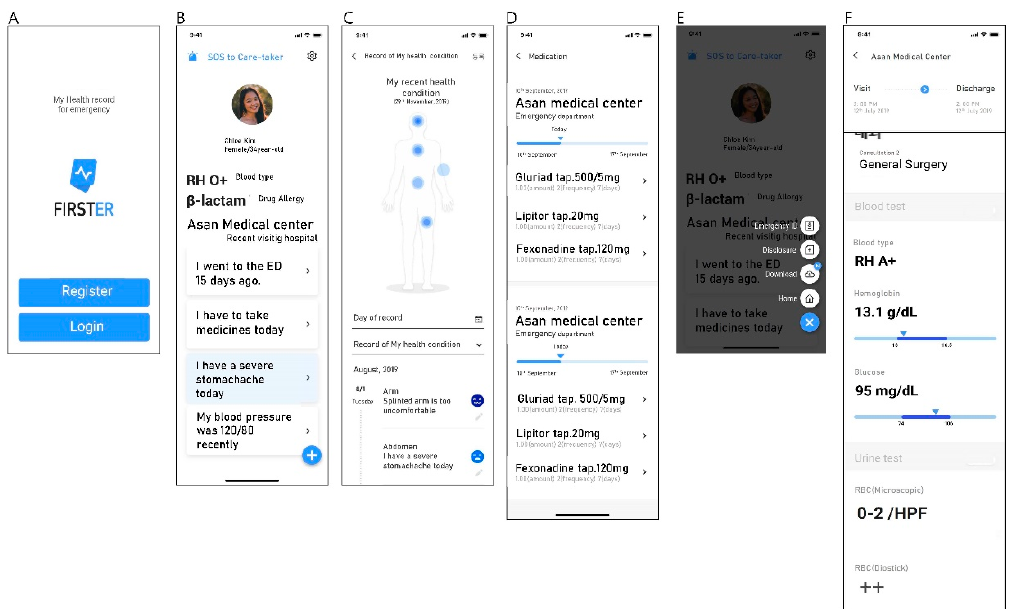
Figure 4. Screenshots of the FirstER user interface (translated to English). ( A ) Introduction page for registration and log-in; ( B ) main page for user’s information, ED visiting history, medication alarms and PGHD at a glance; ( C ) details of PGHD contents: “My recent health condition”; ( D ) prescribed medication (duration, amount, and frequency) and buttons linked to detailed drug information; ( E ) emergency ID, useful information when a user visits an emergency department, and buttons linked to download and “disclosure” PHR data; ( F ) details of My ED records: visiting time, department consulted, and results of blood tests and urine tests. (ED: emergency department, PGHD: patient-generated health data, ID: identification, PHR: personal health